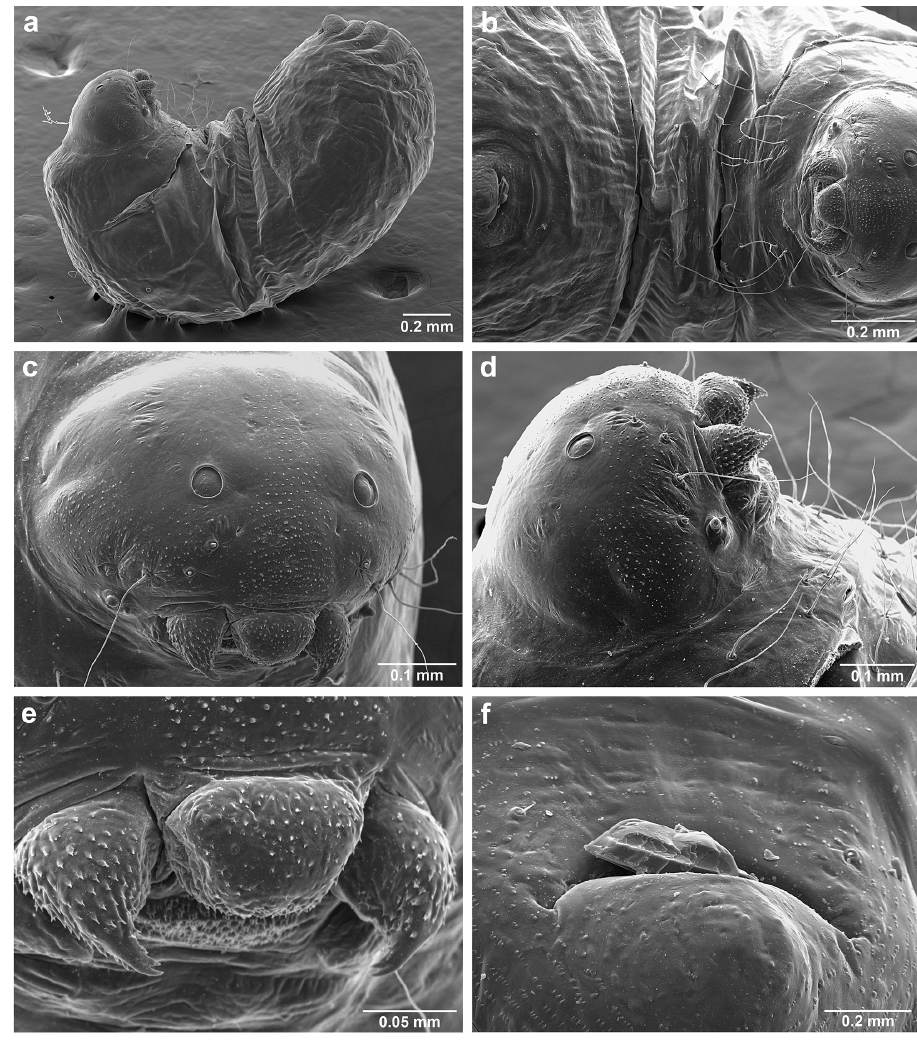
Figure 55. S. saramama larva (USNMENT01125266), SEM images. a Lateral view b ventral view c head, frontodorsal view d head, lateral view e mouthparts f anal setae. dentate spinules, arranged in transverse rows. Numbers of ventral setae: six on each thoracic segment, two on the abdomen (not including anal setae). Single pair of papil- liform setae anterior to anal